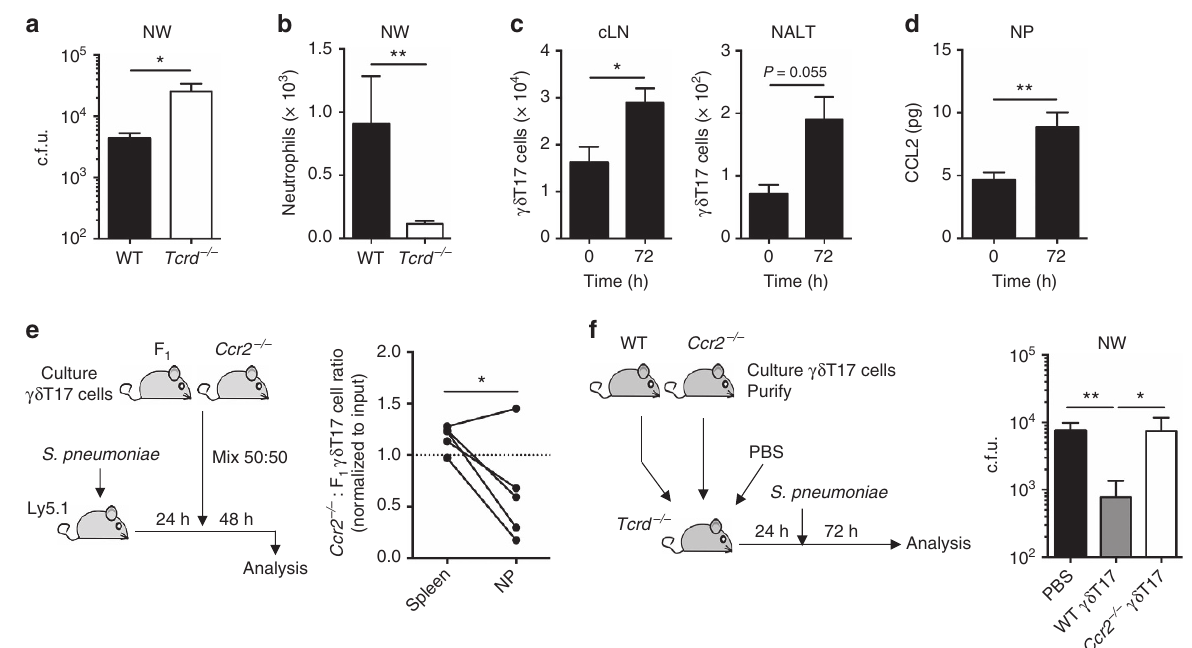
Figure 3 | CCR2 drives protective cd T17 cell responses. ( a ) Colony-forming units (c.f.u.) and ( b ) CD45 þ CD11b þ Ly6G þ neutrophils recovered from nasal wash (NW) of wild type (WT) ( n ¼ 9) and Tcrd (cid:2) / (cid:2) mice ( n ¼ 10) 72h post-infection with S. pneumoniae. ( c ) gd T17 cell numbers in cervical lymph node (cLN) and nasal-associated lymphoid tissue (NALT) and ( d ) ELISA for CCL2 in digested nasal passage (NP) supernatant in unimmunized mice ( n ¼ 7) and at 72h post- S. pneumoniae infection ( n ¼ 13). ( e ) Ly5.1 mice ( n ¼ 5) 24h post- S. pneumoniae infection were transferred i.v. with expanded gd T17 cells from Ccr2 (cid:2) / (cid:2) (CD45.2 þ ) and F 1 (CD45.1 þ CD45.2 þ ) mice. The Ccr2 (cid:2) / (cid:2) :F 1 gd T17 cell ratio in spleen and NP was normalized to input ratio. ( f ) Twenty-four hours prior to S. pneumoniae infection, Tcrd (cid:2) / (cid:2) hosts received PBS ( n ¼ 8) or expanded and purified gd T17 cells from WT ( n ¼ 9) or Ccr2 (cid:2) / (cid:2) ( n ¼ 7) mice. c.f.u. recovered from NW 72h post-infection. Mean ± s.e.m. ( a – d ) Pooled from two experiments. ( a , b ) Mann–Whitney test, ( c , d ) unpaired two-tailed Student’s t -test, ( e ) paired two-tailed Student’s t -test, ( f ) Kruskal–Wallis test with Dunn’s multiple comparisons test. * P o 0.05, ** P o